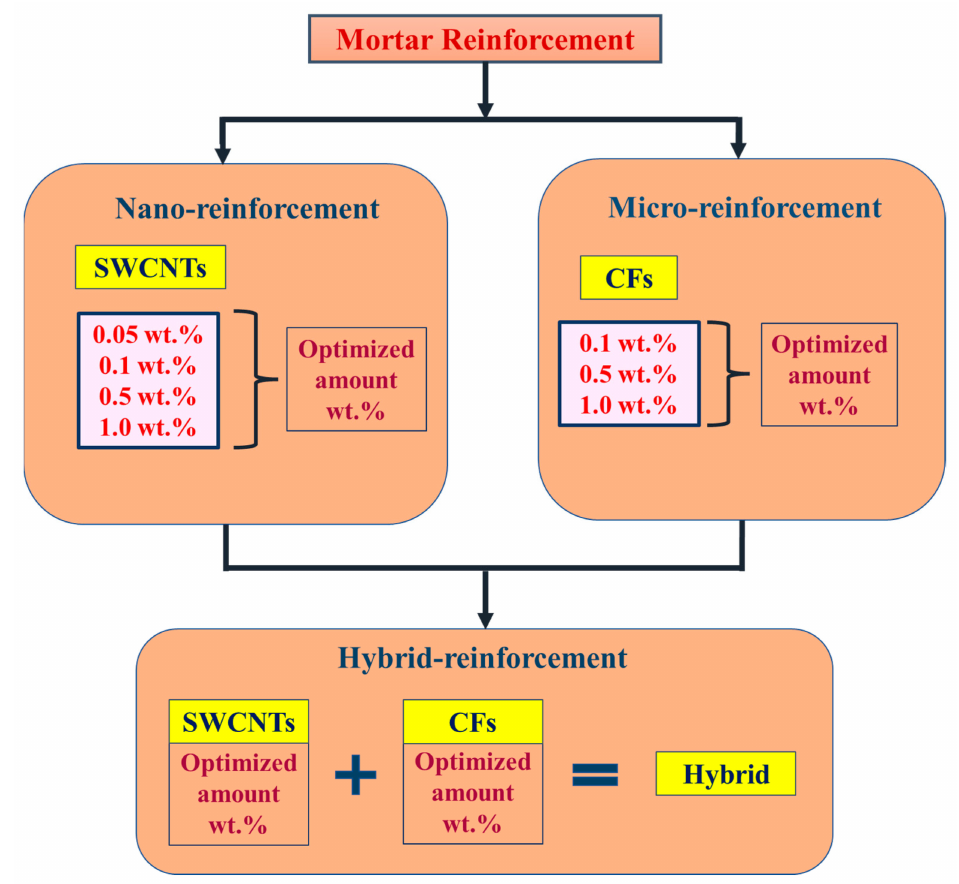
Figure 2. Flowchart of the experimental process of nano-, micro-, and hybrid mortar